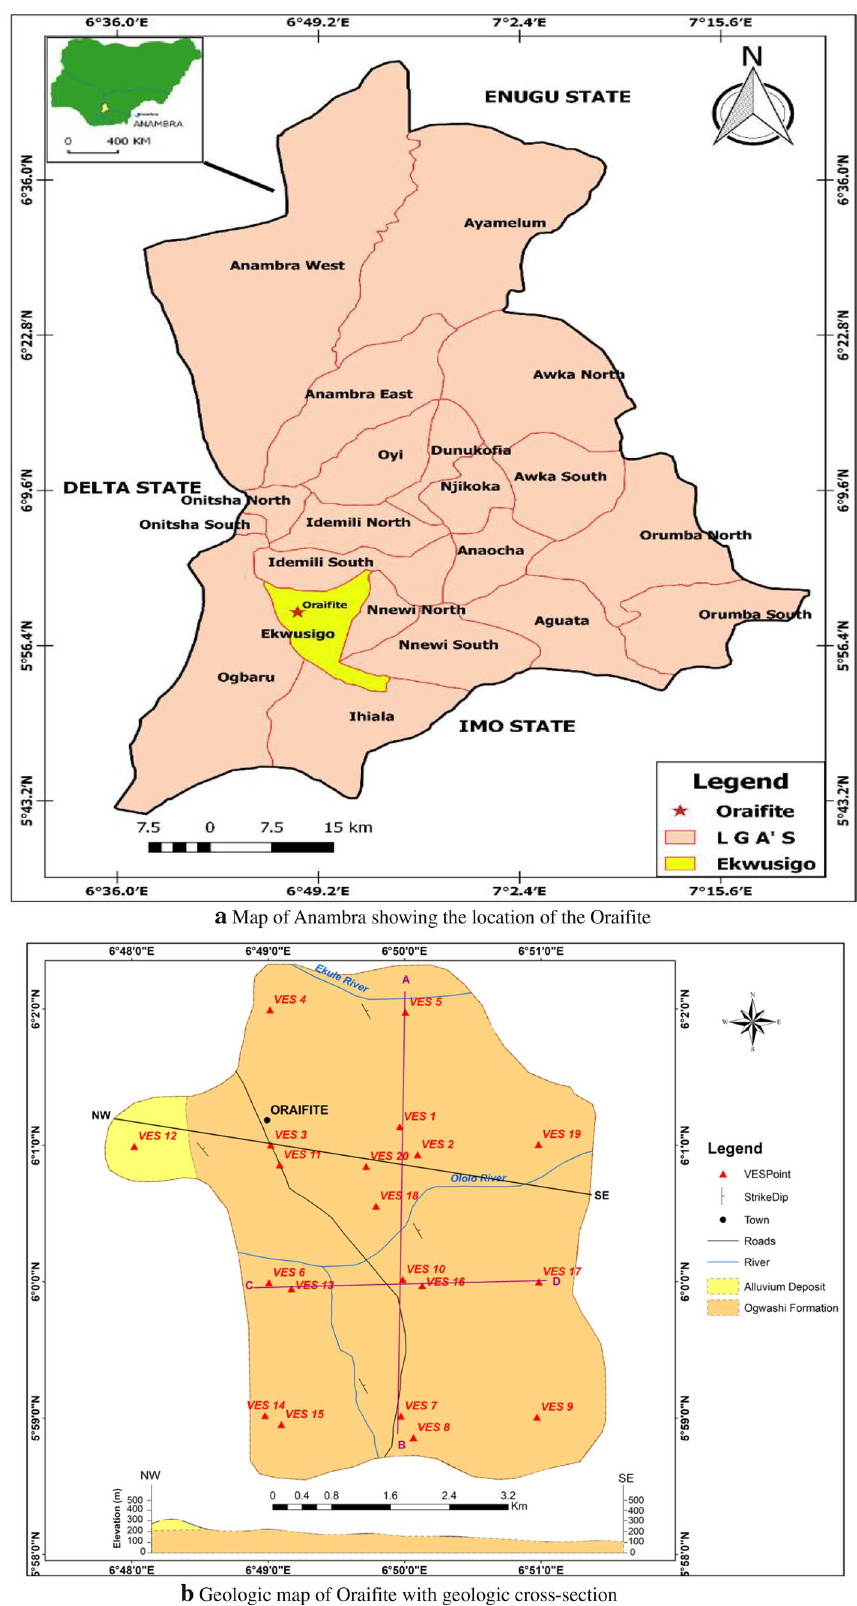
Fig. 1 a Map of Anambra showing the location of the Oraifite. b Geologic map of Oraifite with geologic cross